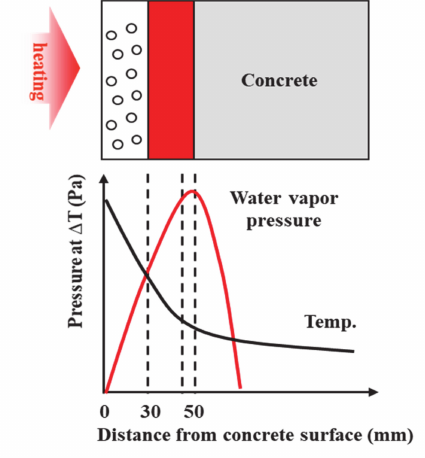
Figure 1. Change of water vapor pressure in concrete with temperature.